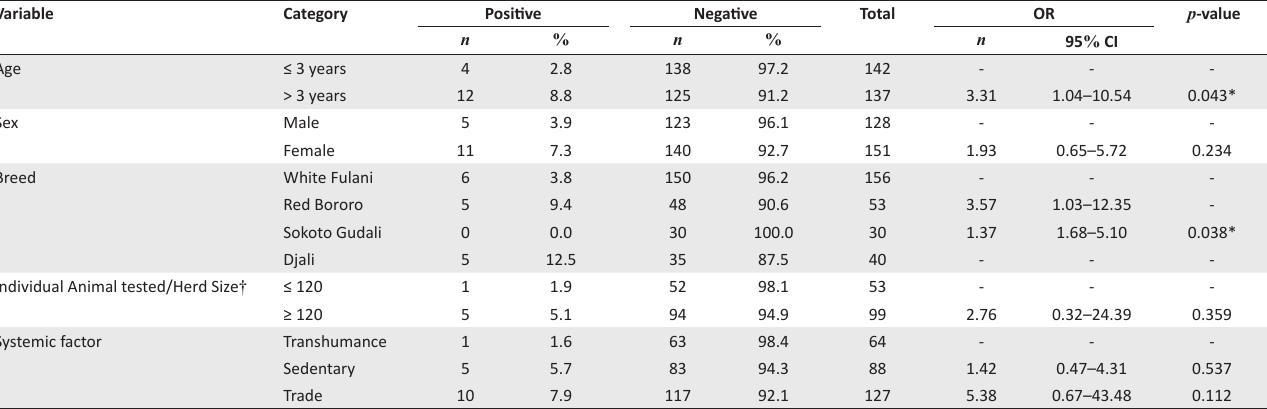
TABLE 3: Risk factors associated with seroprevalence of bovine brucellosis as measured by competitive enzyme-linked immunosorbent assay in three cattle production systems in Yewa Division, Nigeria. Variable